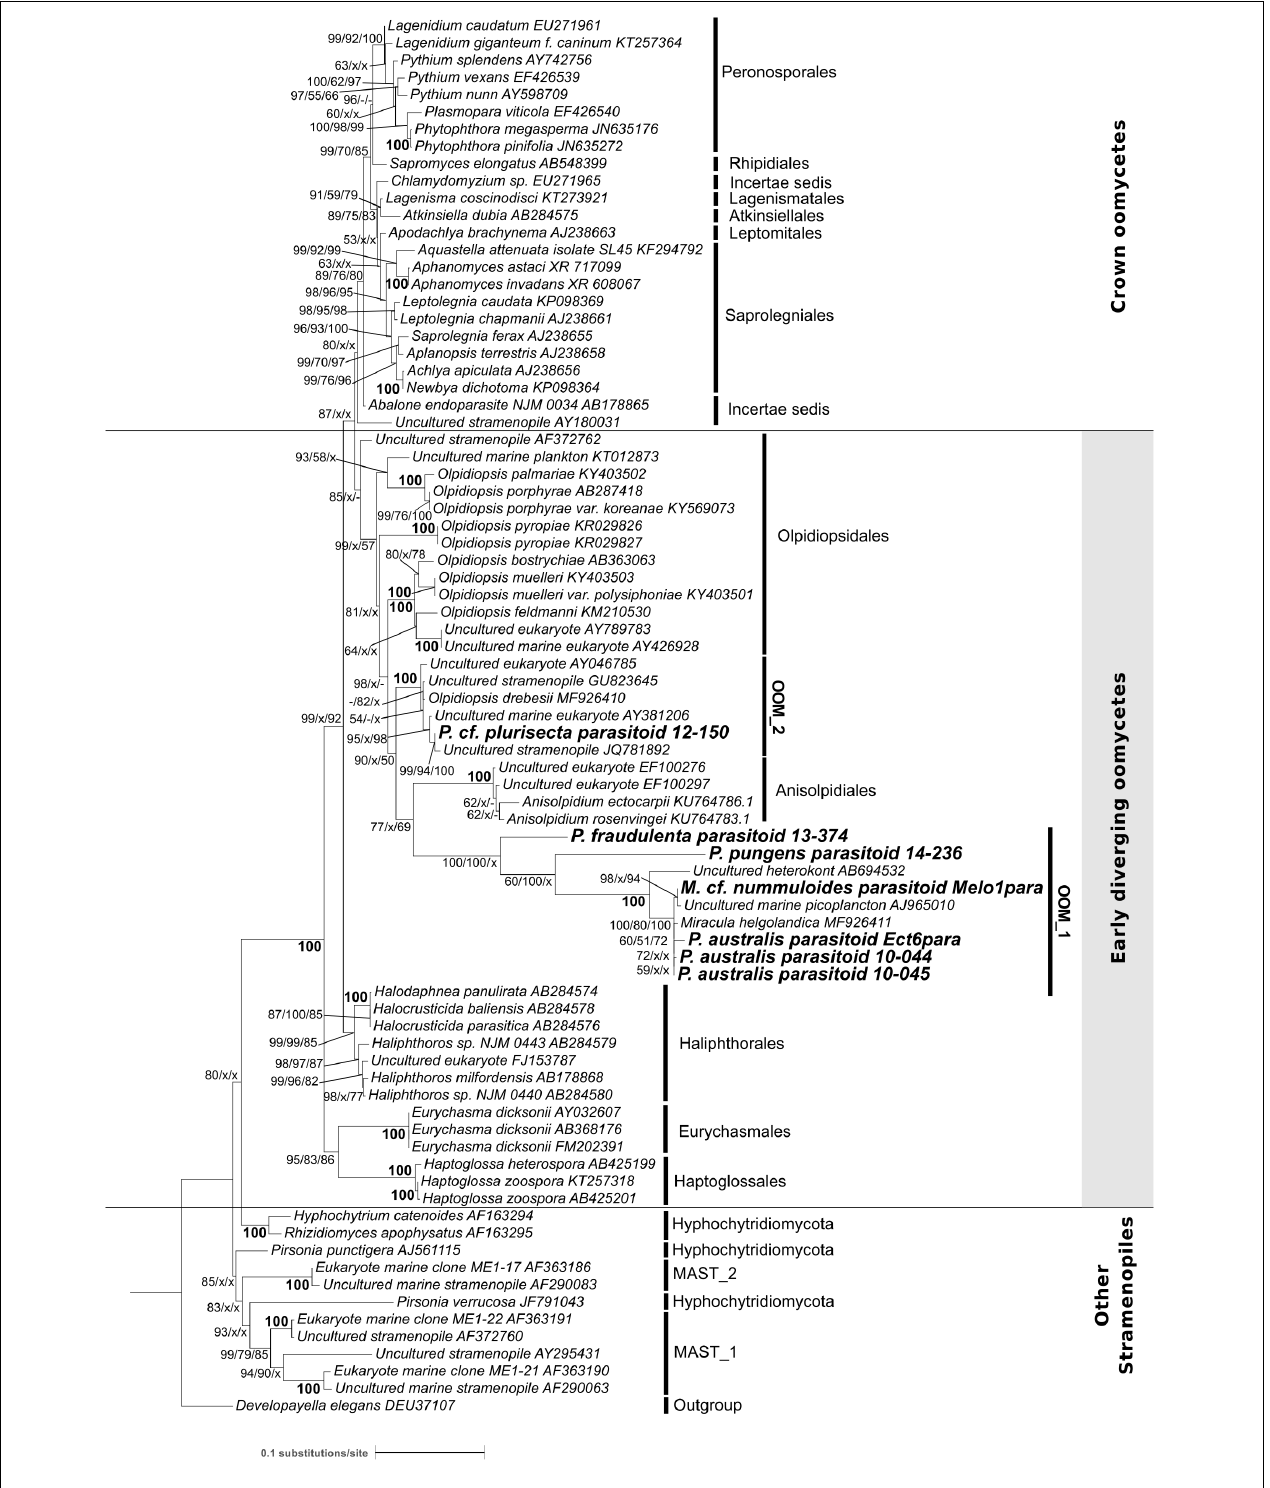
FIGURE 3 | Maximum likelihood phylogenetic tree reconstruction based on partial 18S rDNA genes of novel diatom parasitoids within the Oomycota (Stramenopila), inferred from 81 sequences on 1,206 positions. New sequences are in bold and they are named according to the host species and the sample ID within the new clades OOM_1 and OOM_2 (details in Table 1 ). Bootstrap values (1,000 replicates for ML and NJ, 100 for MP) are shown at each node as a percentage for the three computational methods tested, with the following order: maximum likelihood, neighbour joining and maximum parsimony. X, node not supported; –, bootstrap support < 50%. Bold numbers indicate agreement on the same bootstrap value for the three methods. Refer to the alignment in Supplementary Data Sheet S2 .